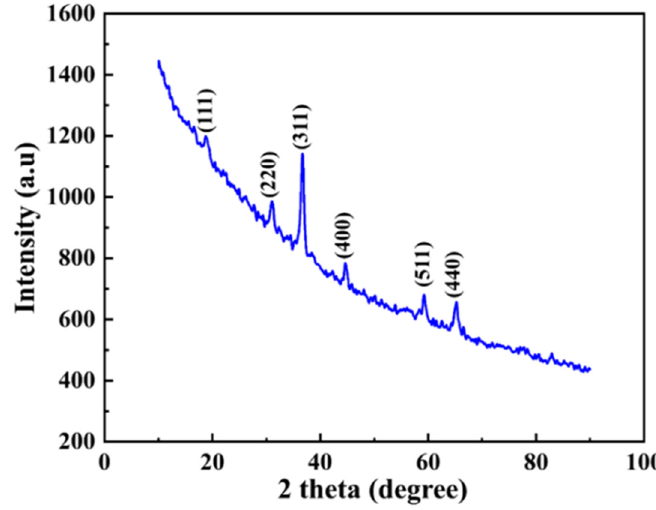
Figure 3. X-ray diffraction (XRD) pattern for Co 3 O 4 NPs.